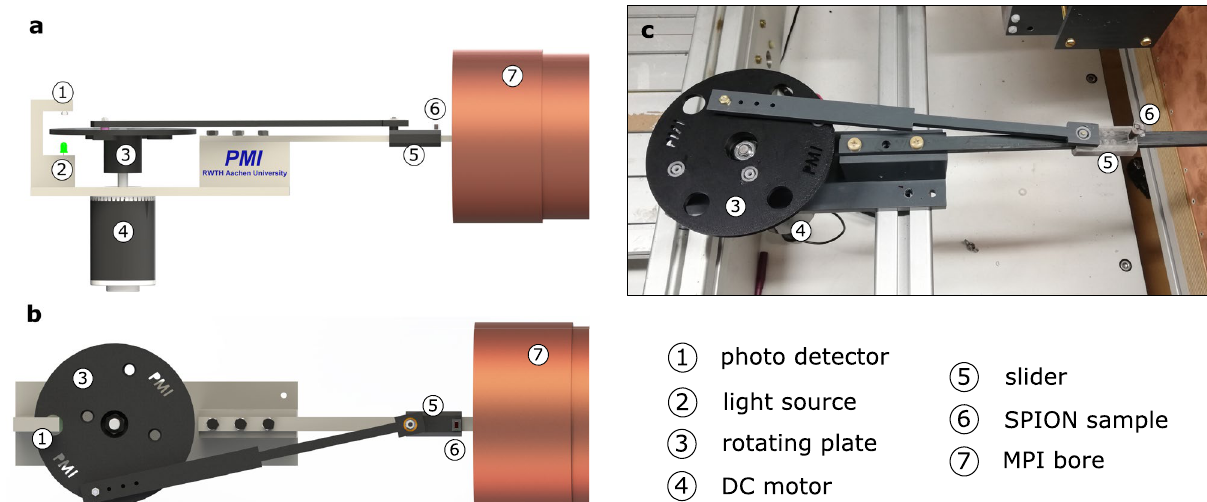
Figure 6. Custom designed mechanical assembly enabling the oscillation of a SPION sample inside the MPI bore. ( a ) CAD design, side view. ( b ) CAD design, top view. ( c ) Photography of manufactured assembly. The sample (6) is fixed on a slider (5) that is connected to a rotating plate (3) via a stiff rod. The rotating plate is driven by a DC motor (4), which is connected to a pulse-width modulation rotational speed controller. Calibration of “ground truth” sample velocity is performed by measuring the rotation frequency of the rotating plate. The rotation period is determined from the time difference between two consecutive light pulses (2) that are sensed by a photo detector